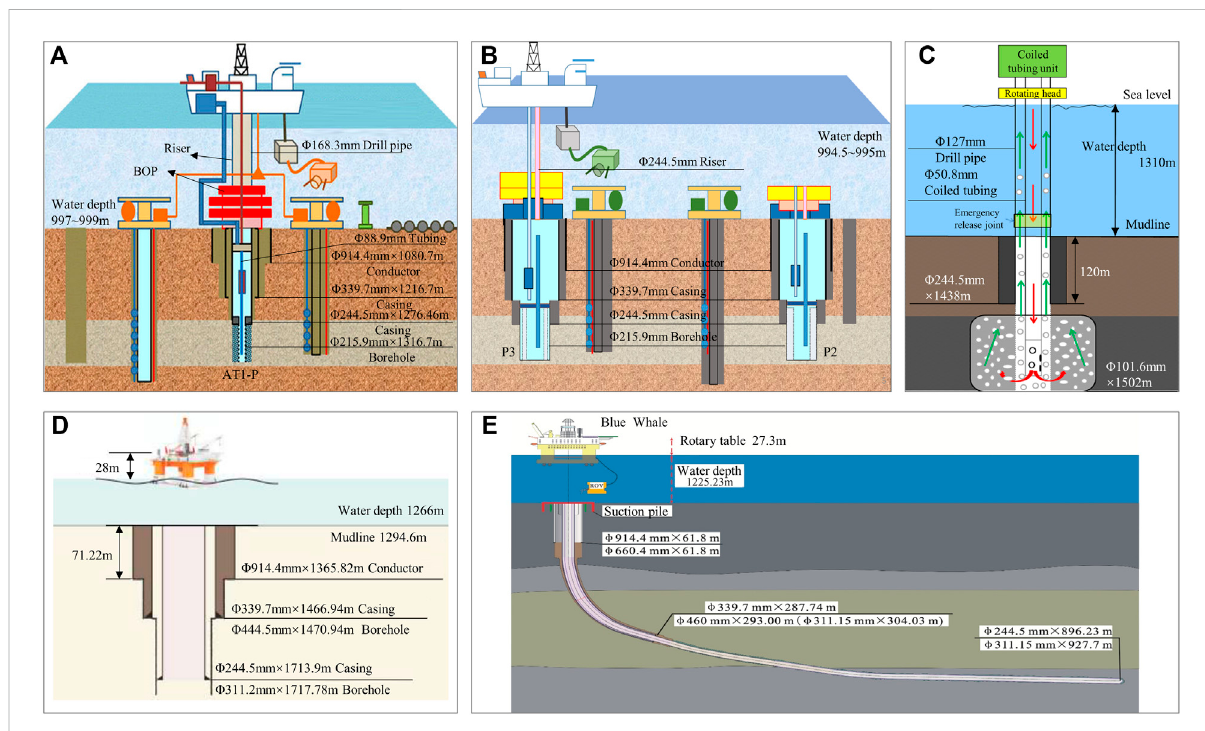
FIGURE 4 Wellbore structures of offshore gas hydrate pilot production wells. (A) the fi rst offshore pilot production well in Japan, (B) the second offshore pilot production well in Japan, (C) the fi rst offshore solid fl uidization pilot production well in China, (D) the fi rst offshore depressurization pilot productionwellinChina,and (E) thesecondoffshoredepressurizationpilotproductionwellinChina.(Matsuzawaetal.,2014;Yamamotoetal.,2014; Li et al., 2019; Yamamoto et al., 2019; Ye et al., 2020).